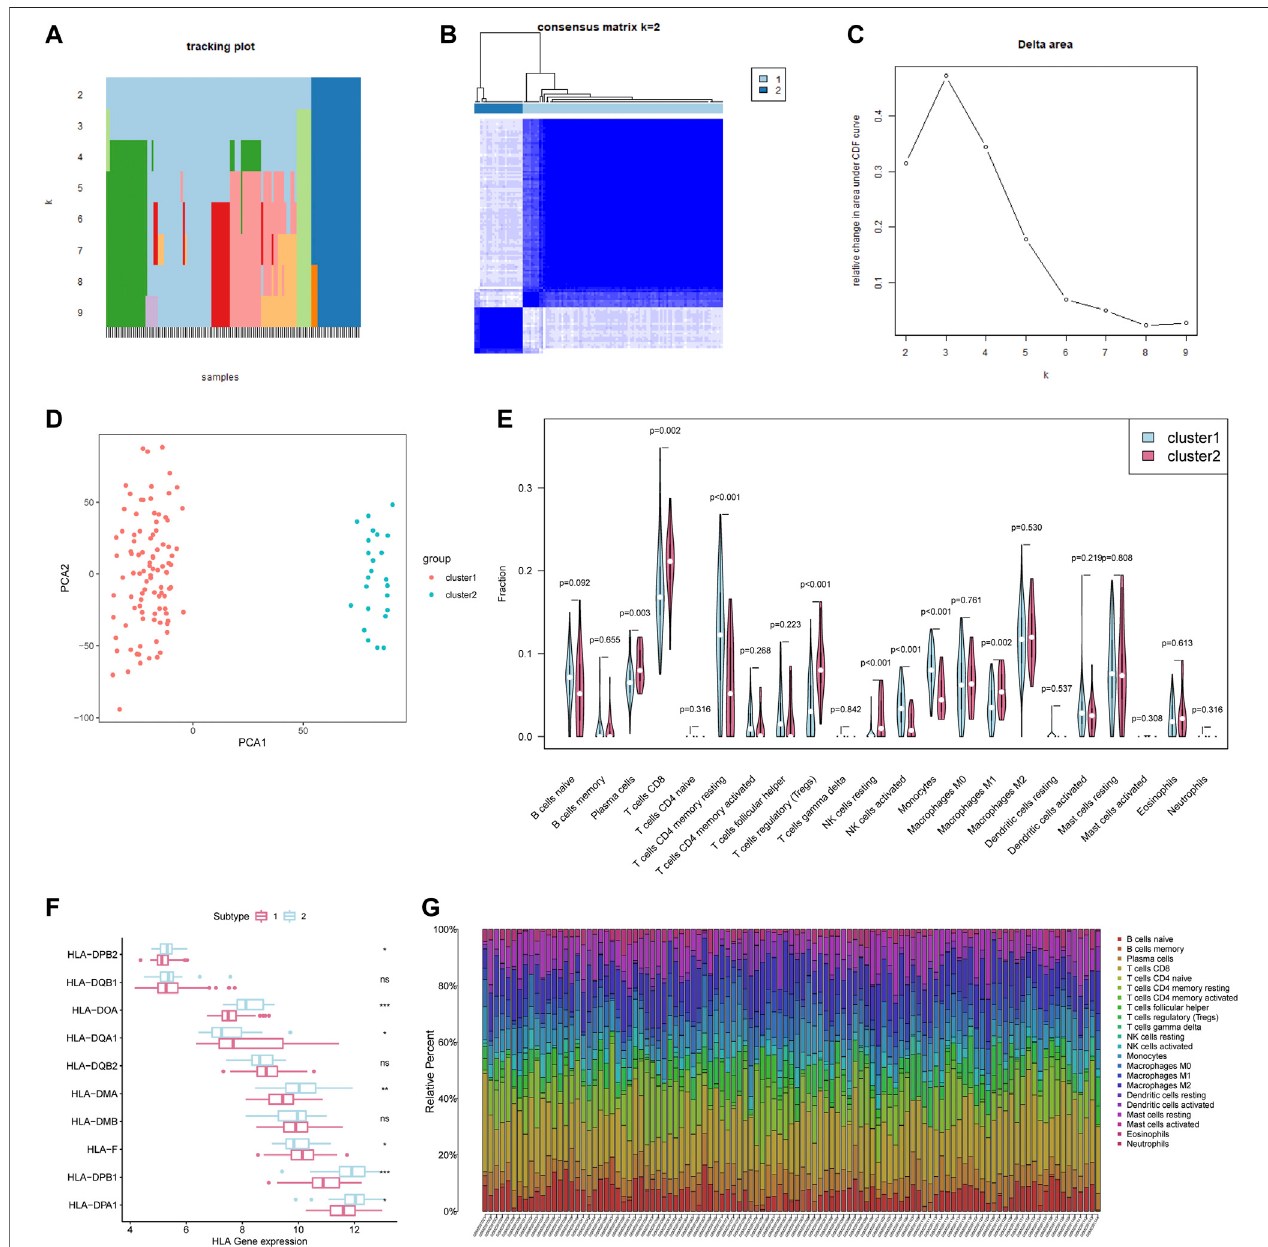
FIGURE5| ConsensusClusteringof24m6Aregulatorsidenti fi edtwoclustersofpatientswithdifferentTMEcellin fi ltrationcharacteristics. (A) Thetrackingplotfork (cid:1) 2tok (cid:1) 9. (B) Theheatmap fork (cid:1) 2. (C) RelativechangeinareaunderCDF curve fork (cid:1) 2 – 9. (D) Principalcomponent analysisofthetotalRNAexpression pro fi le. (E) Differentimmunecellcontentintumortissue.ThegreenrepresentsCluster1andtheredrepresentsCluster2. (F) HLAgeneexpressionincluster1/2. (G) RelativePercent of different immune cells in each